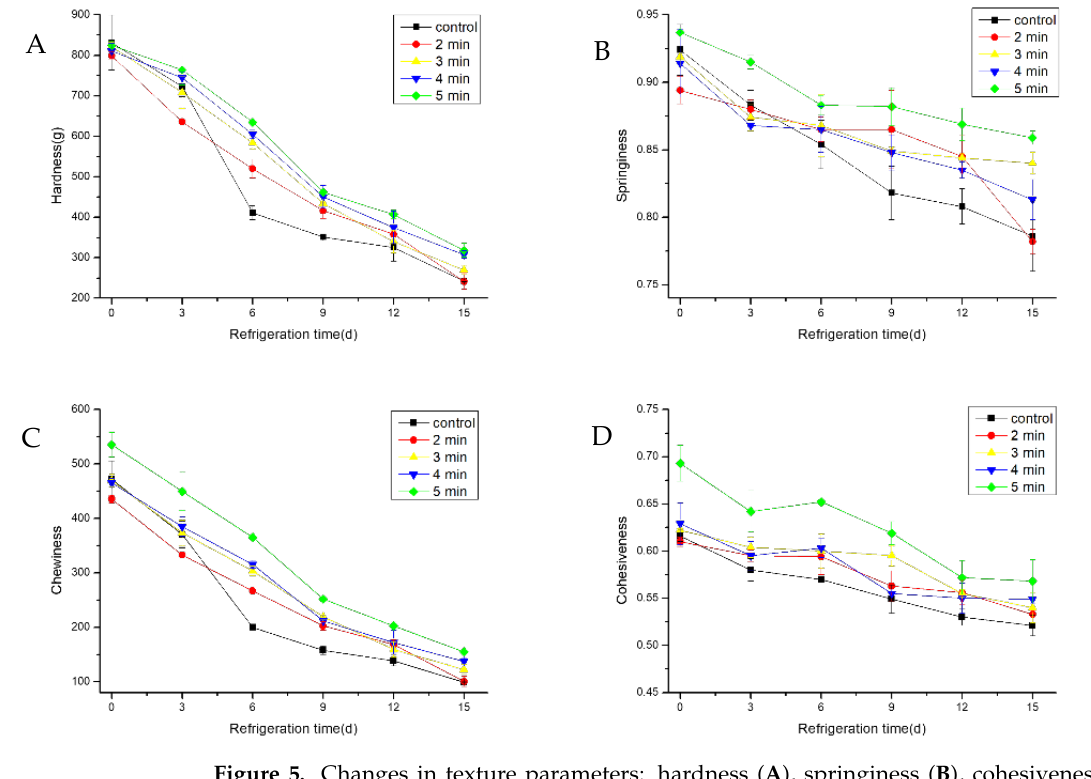
Figure 5. Changes in texture parameters: hardness ( A ), springiness ( B ), cohesiveness ( C ), and chewiness ( D ) of cold stored hairtail fish exposed to CAP at 50 kV voltage for various treatment times: 2, 3, 4, and 5 min. The non-treated sample was included as a control.